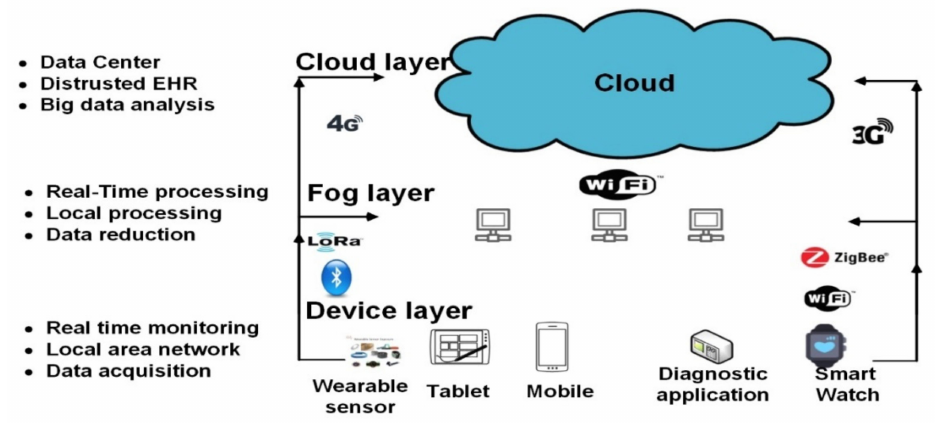
Figure 4. Fog computing layers in